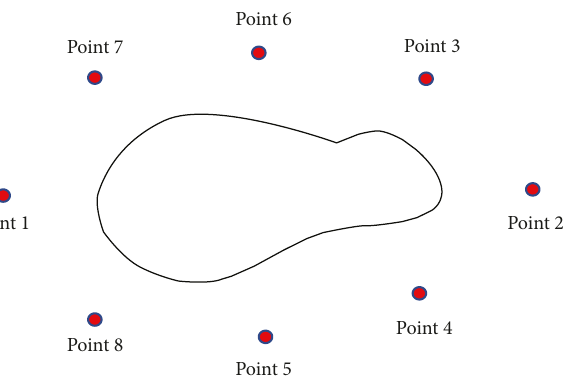
Figure 4: Observation points of optimized asymmetric cross- section